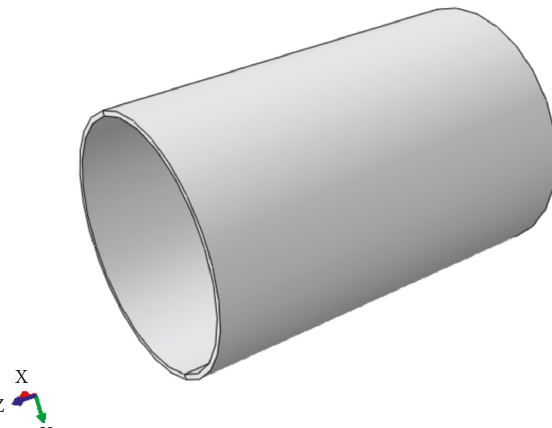
Figure 1: Modeling drawing of the flawless pipeline.